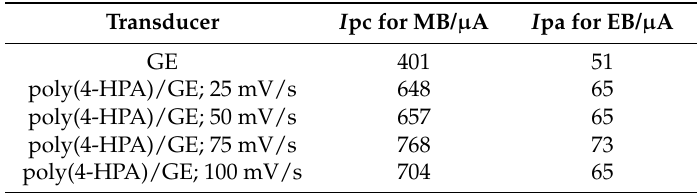
Table 5. Current peak values for MB reduction and EB oxidation for GE and poly(4-HPA)/GE modified at different scan rates containing the immobilized oligonucleotide (mean, n =